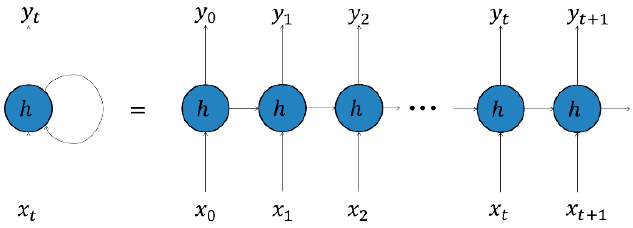
Figure 7. Recurrent neural network.